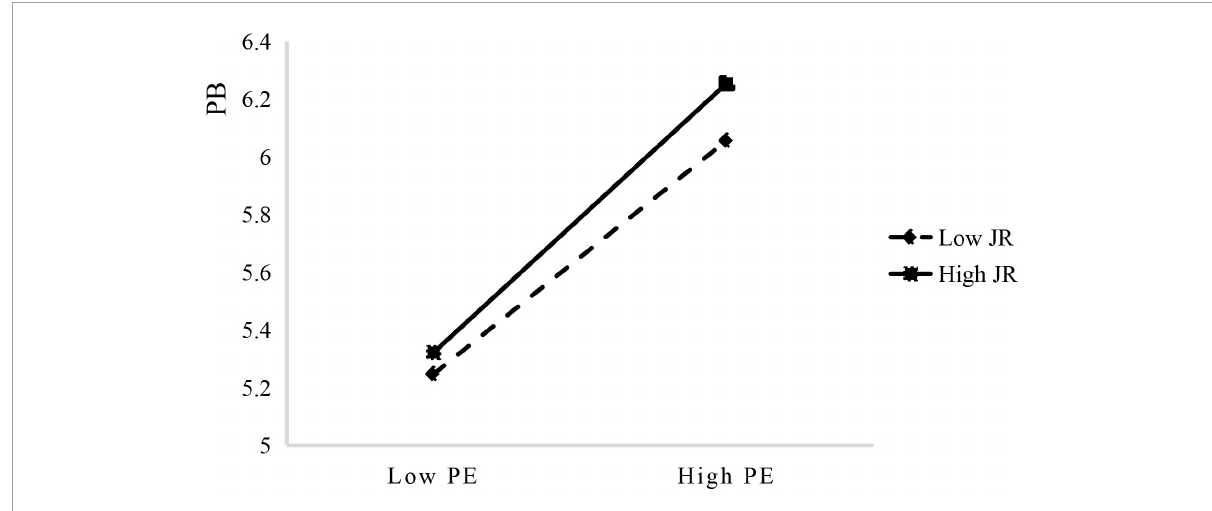
FIGURE3 The moderating effect of job relevance (JR) on the relationship between peak experience (PE) and proactive behavior